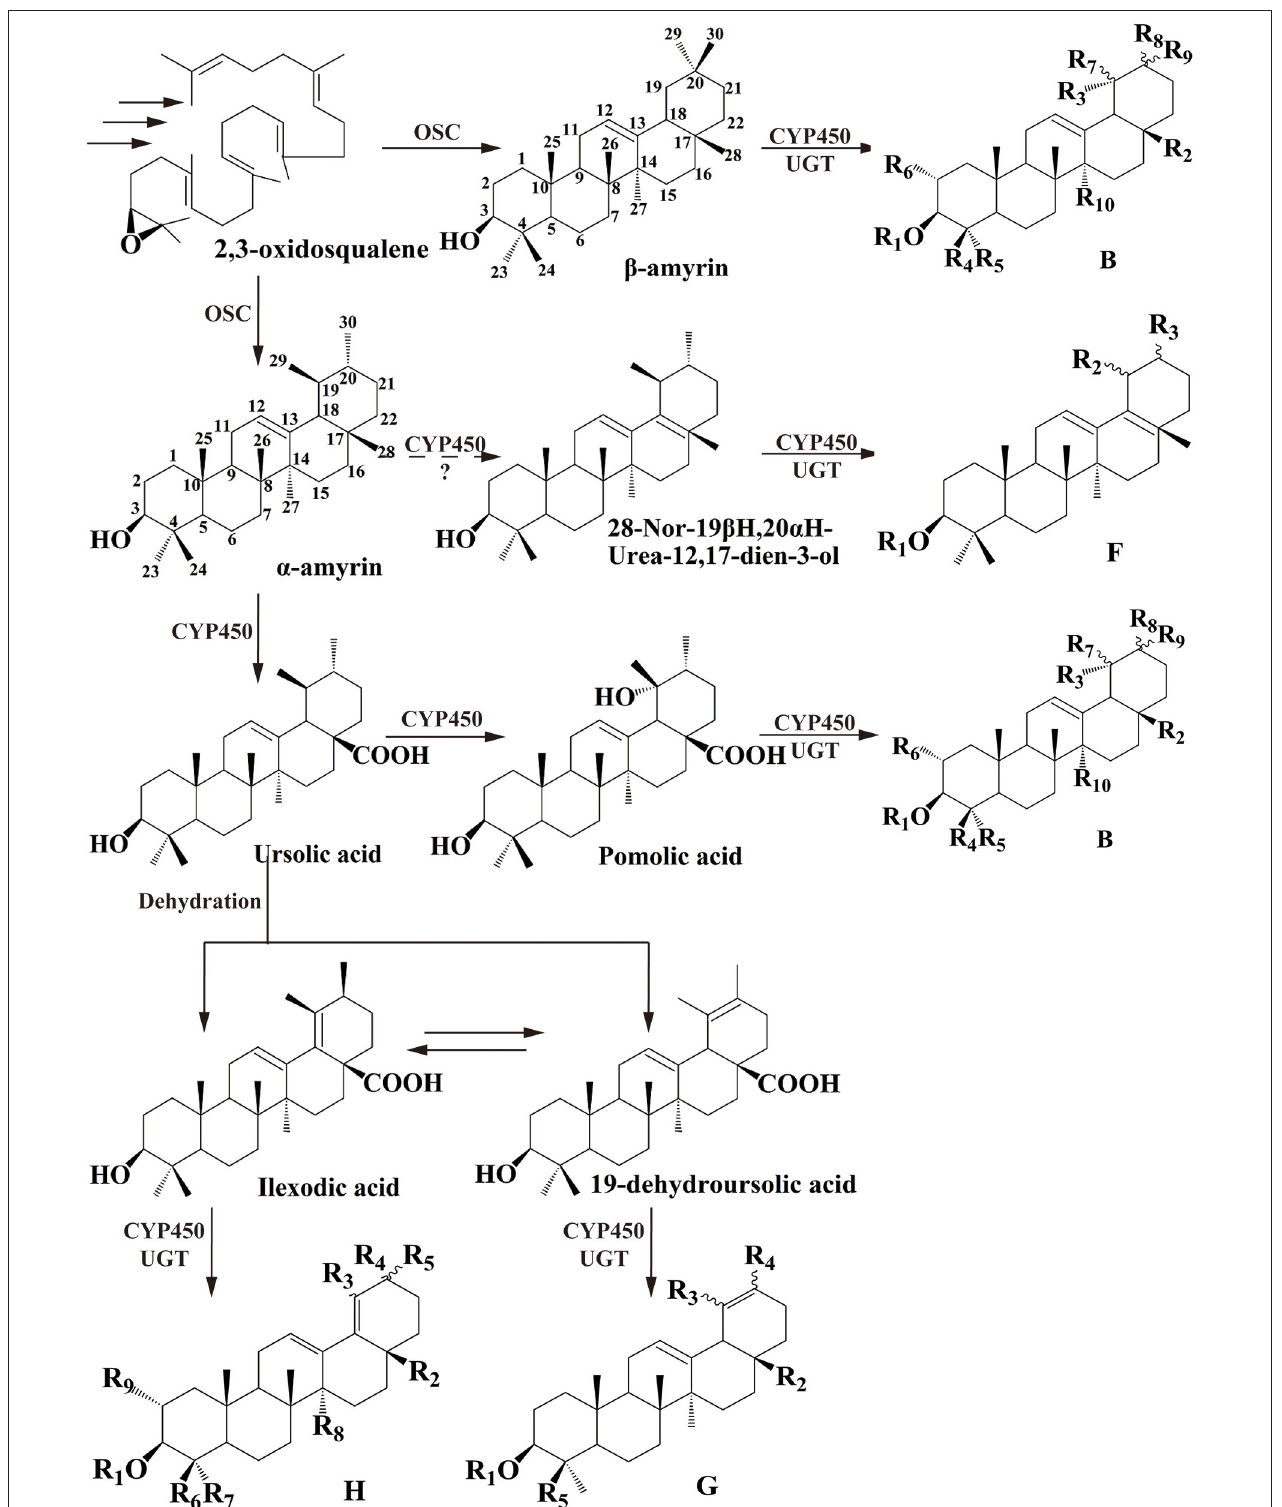
FIGURE 1 | Proposed downstream biosynthetic pathway of triterpenoid saponins of common structures in I. pubescens and I. asprella . The structure numbers were corresponding to Figure S8 .